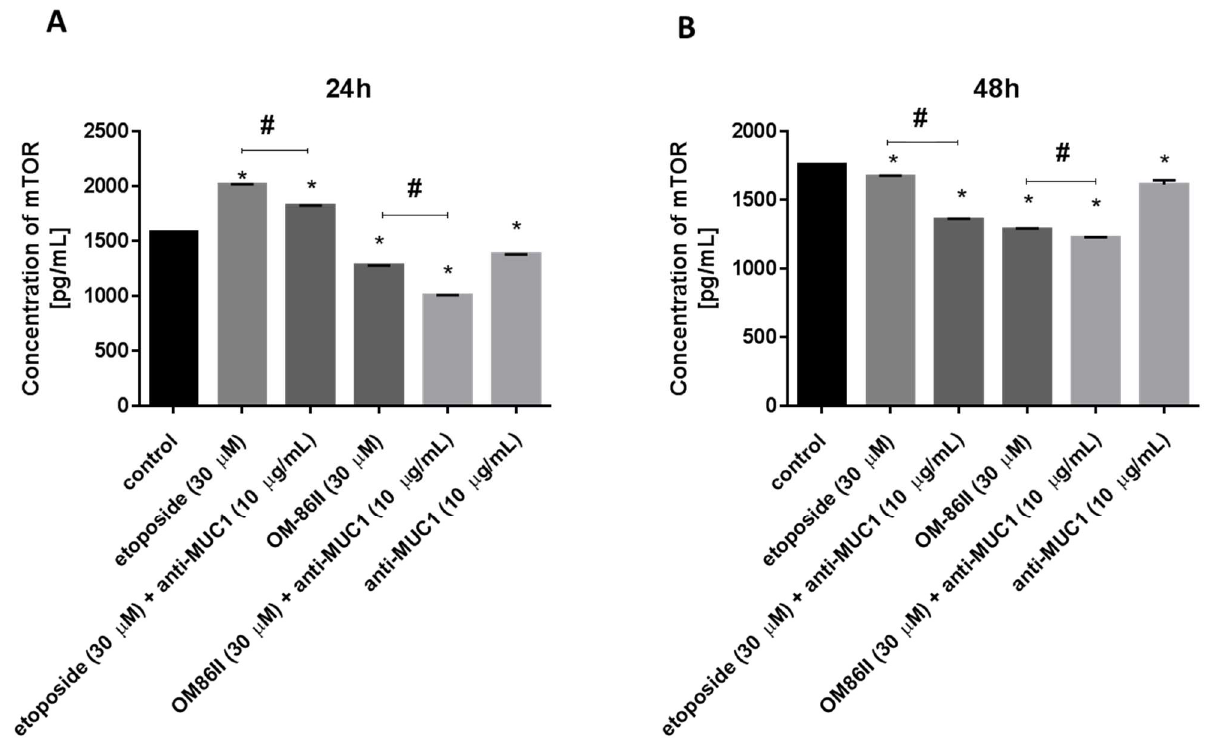
Figure 7. The concentration of mTOR in human gastric cancer AGS cells after 24 h ( A ) and 48 h ( B ) of incubation with anti-MUC1 (10 µg/mL), OM-86II (30 µM), OM-86II + anti-MUC1 (30 µM + 10 µg/mL), etoposide (30 µM) and etoposide + anti-MUC1 (30 µM + 10 µg/mL). Data are presented in ng/mL. * p < 0.05 vs. control group; # p < 0.05. MUC1, mucin-1; OM-86II, octahydropyrazin[2,1-a:5,4-a (cid:48) ]diisoquinoline